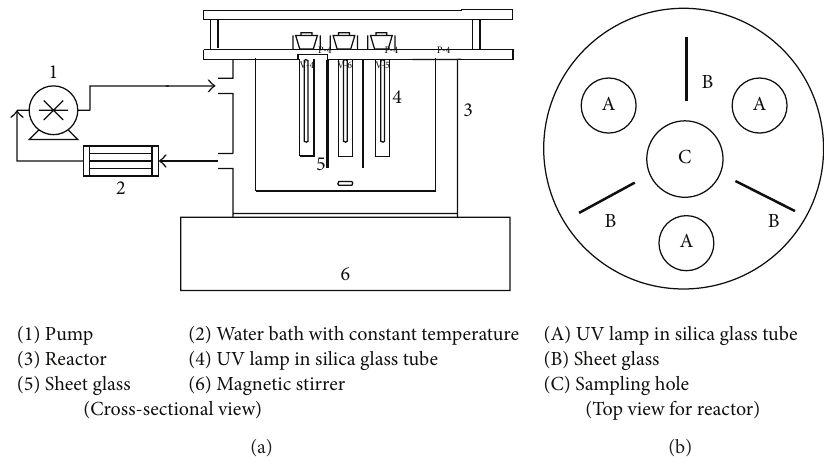
Figure 1: Equipment for TiO 2 -film